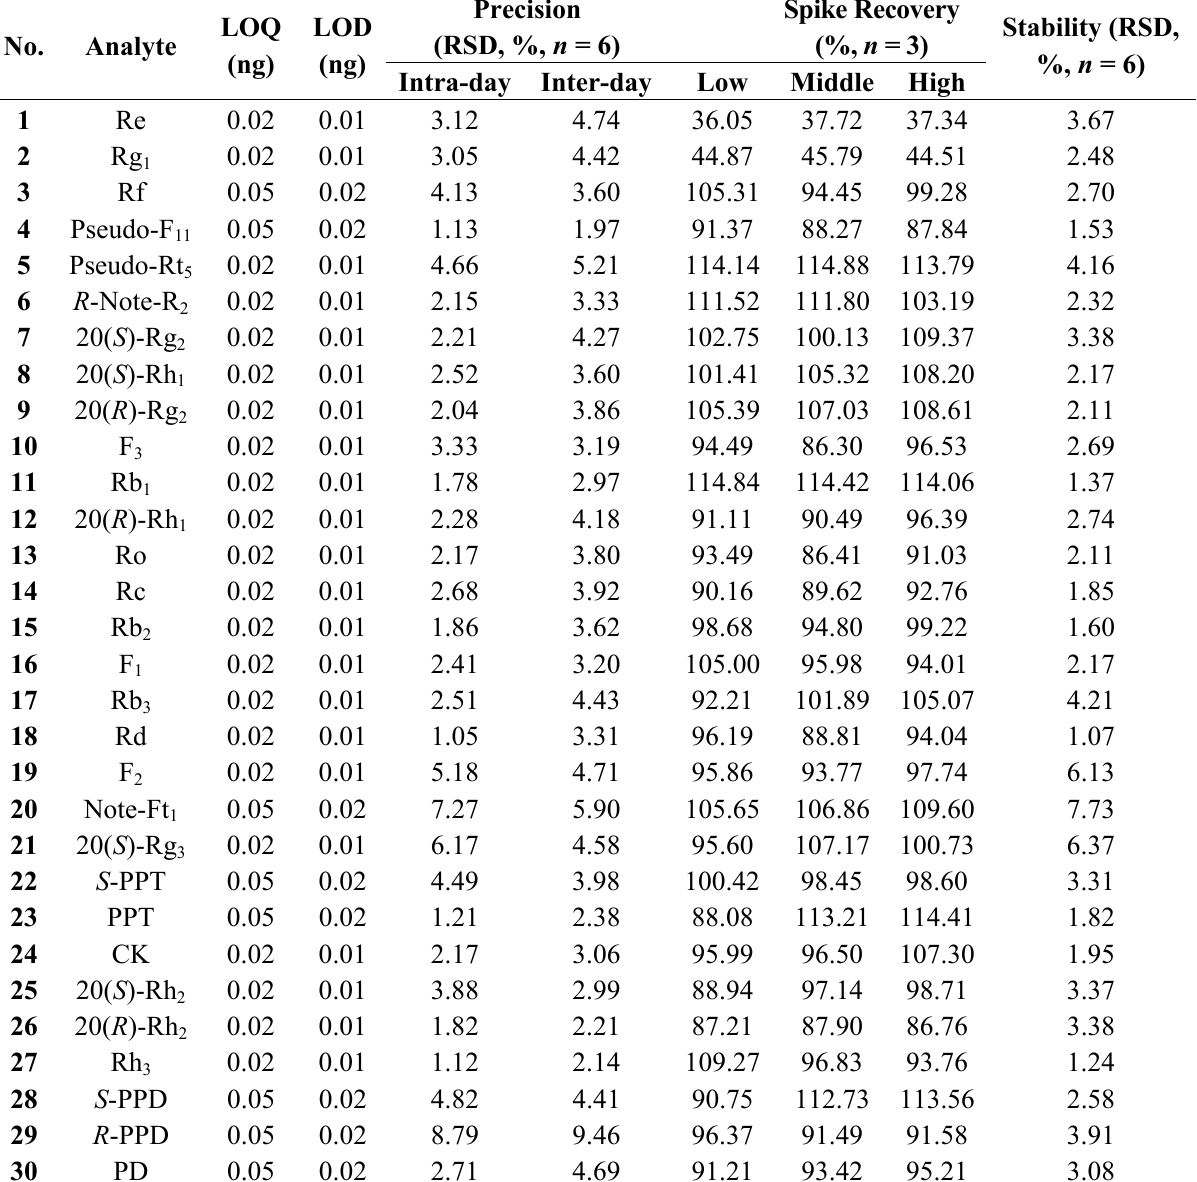
Table 2. Sensitivity, precision, accuracy and stability of the